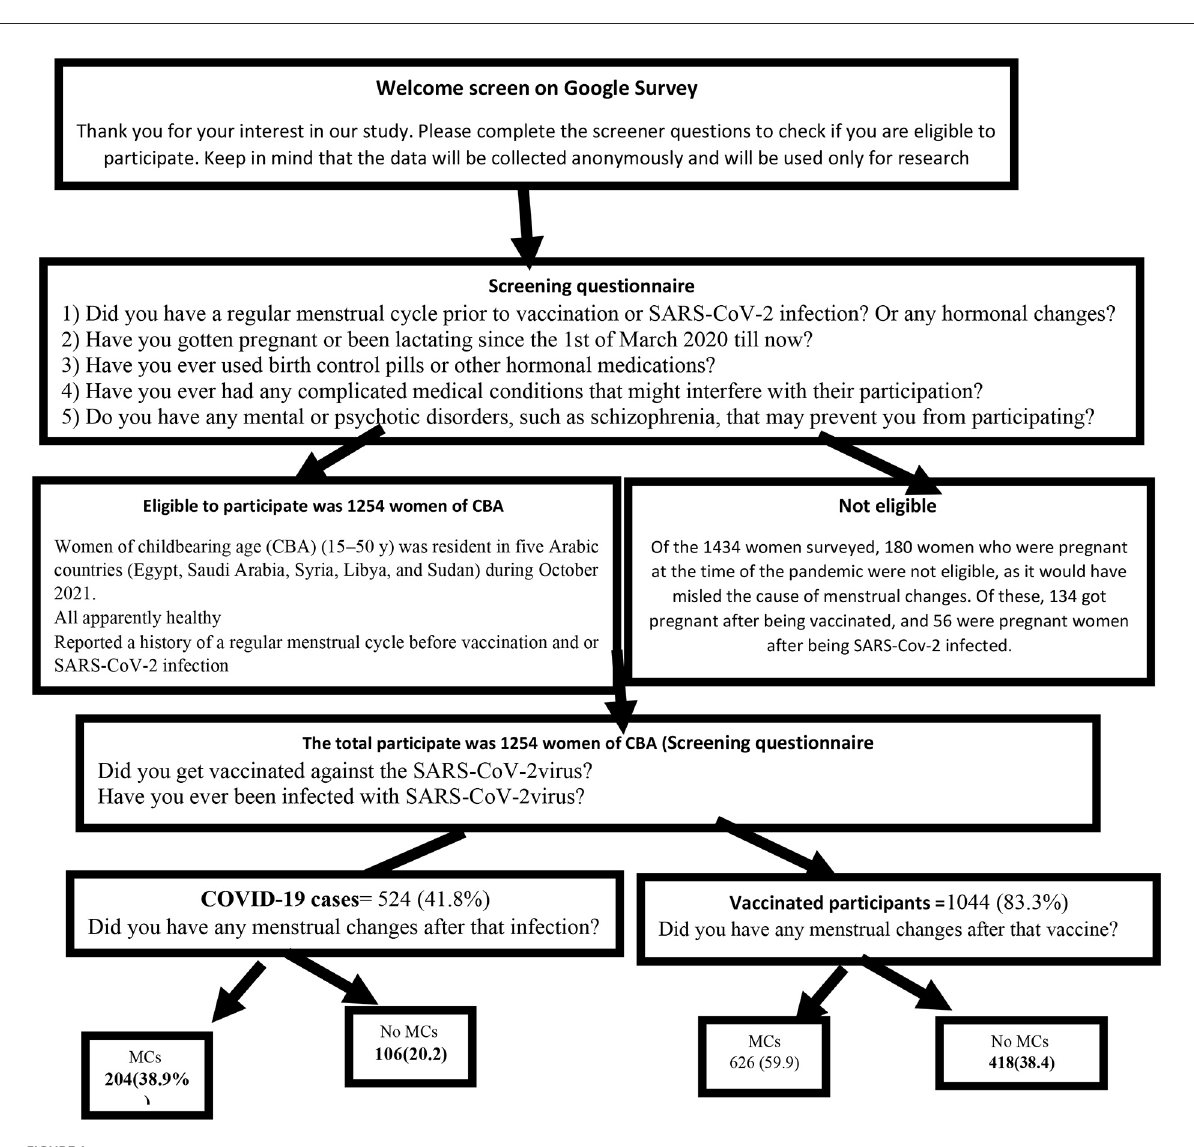
FIGURE1 Survey recruitment flow